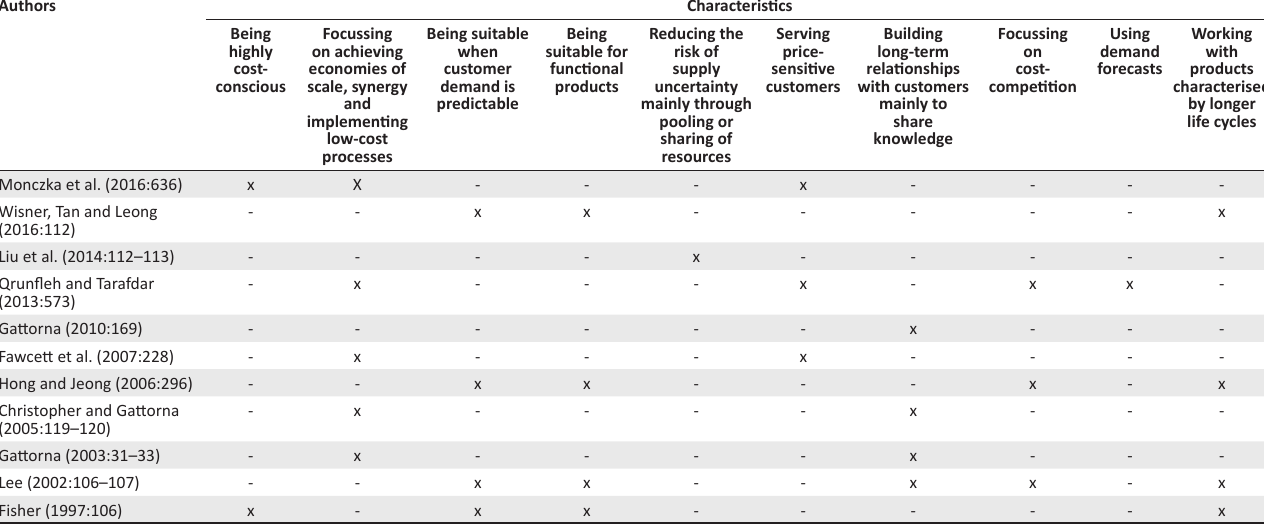
TABLE 2: Characteristics of a supply chain strategy orientated towards cost-efficiency based on literature. Authors Characteristics